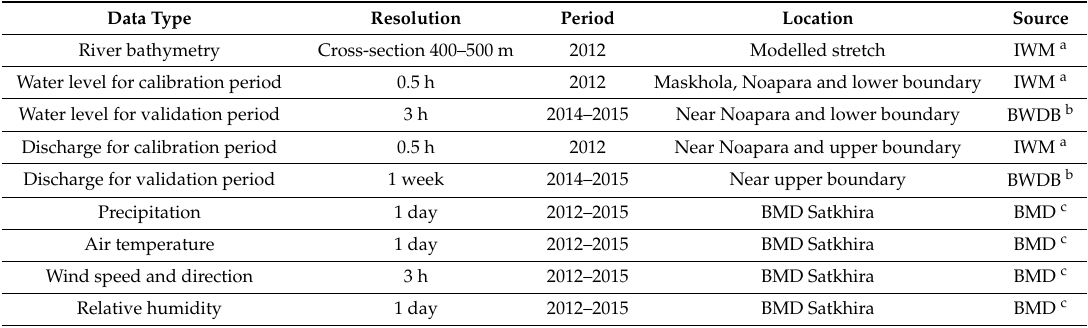
Table 1. Input data used for the hydrodynamic model.